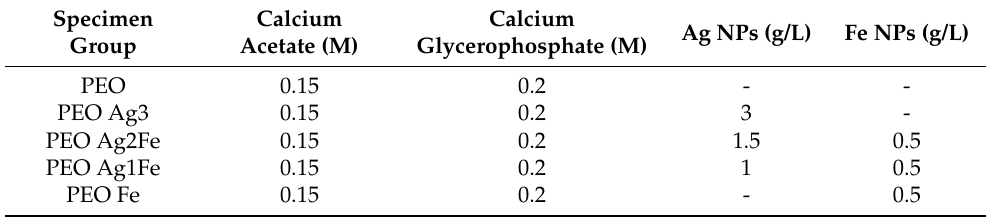
Table 1. Experimental groups and their corresponding compositions of the PEO